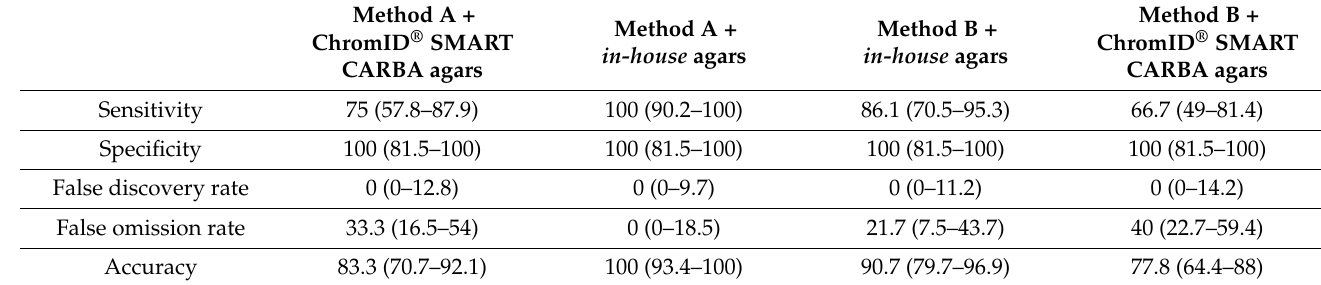
Table 1. Summarized results on the repeated isolation of CPE from the spiked fecal samples (calculation by combining the OXA and CARBA- site of the ChromID ® SMART CARBA agars and of the McC + CTX + MEM and the McC + MEM plate of the in-house agar). Method B is the modified method. Corresponding exact 95% confidence intervals are provided in